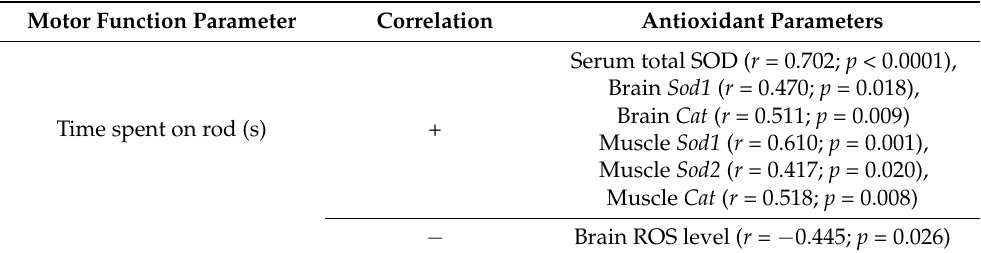
Table 2. Correlations between motor function and antioxidant parameters after 8 weeks of supple- mentation in the rat model of PD.